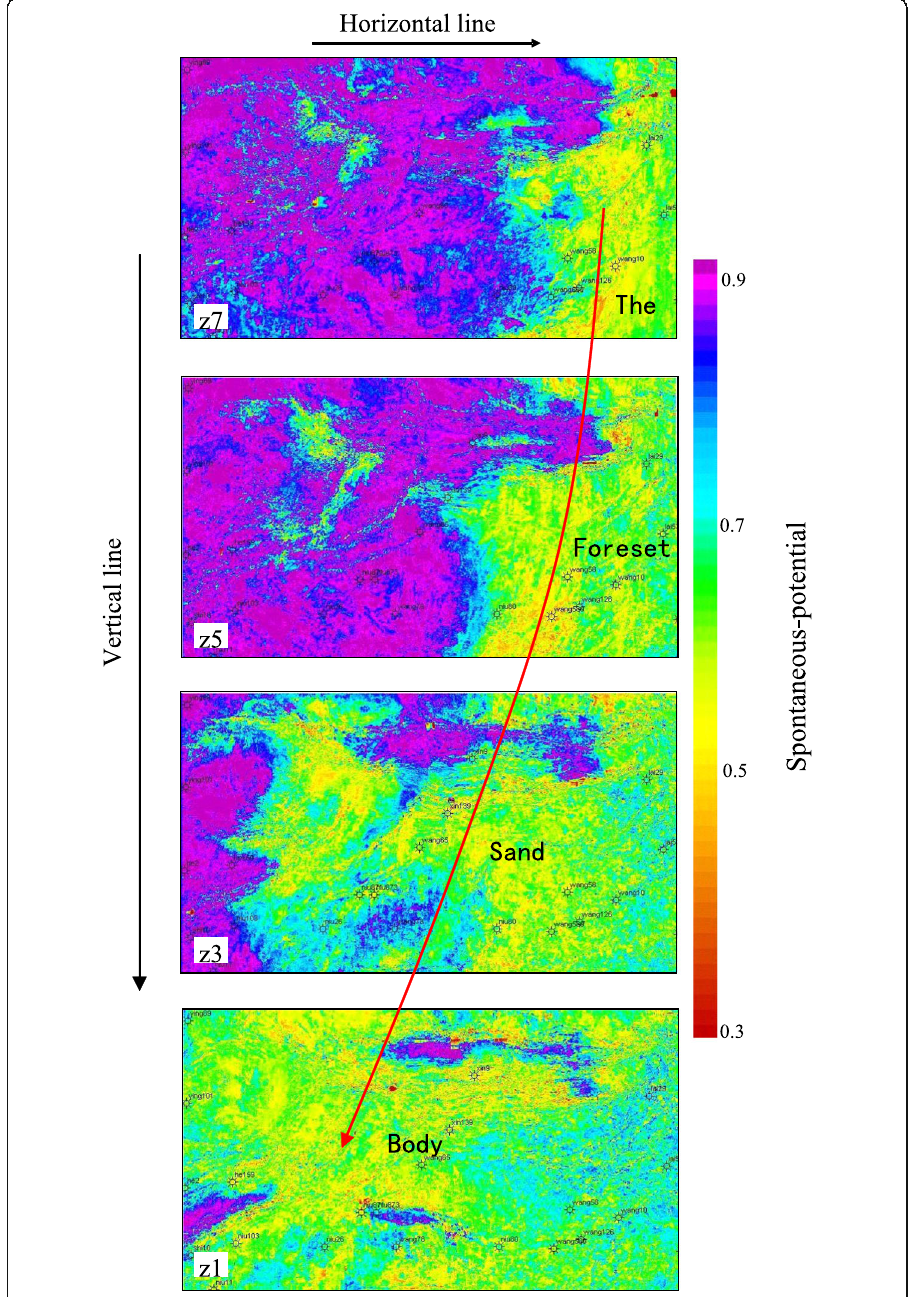
Fig. 6 Horizon slice of the intermediate section in Member 3 of the Shahejie Formation in the Dongying Delta as obtained by multi-attribute SP inversion. The yellow is sand, green is silt, purple is mud, and blue is